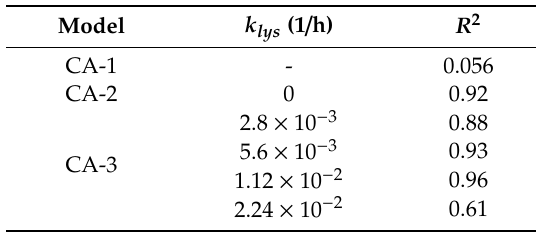
Table 2. Coefficients of determination for straight lines fitted to relationships 1/ ( ) Table 2. Coe ffi cients of determination for straight lines fitted to relationships 1/ ρ obtained using cellular automata-based models. using cellular automata-based models.